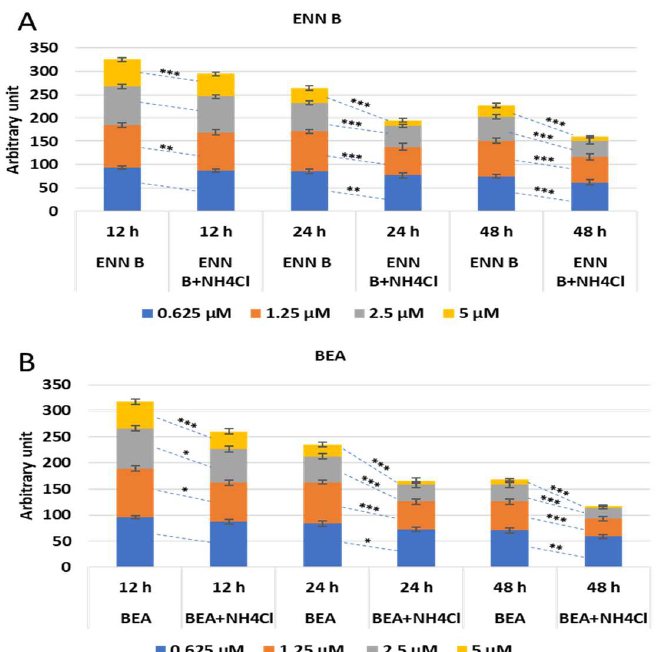
Figure 12. The cytotoxic effect of ENN B and BEA in the presence and absence of 20 mM ammonium chloride. ( A ) KB-3-1 cells were treated with 1.25, 2.5 and 5 µ M ENN B in the presence and absence of 20 mM ammonium chloride. ( B ) KB-3-1 cells were treated with 1.25, 2.5 and 5 µ M BEA in the presence and absence of 20 mM ammonium chloride. The data were analyzed using two-way ANOVA with Dunnett’s post hoc analysis (* p < 0.05; ** p < 0.01; *** p < 0.001; N = 7). Statistics were calculated using GraphPad Prism.